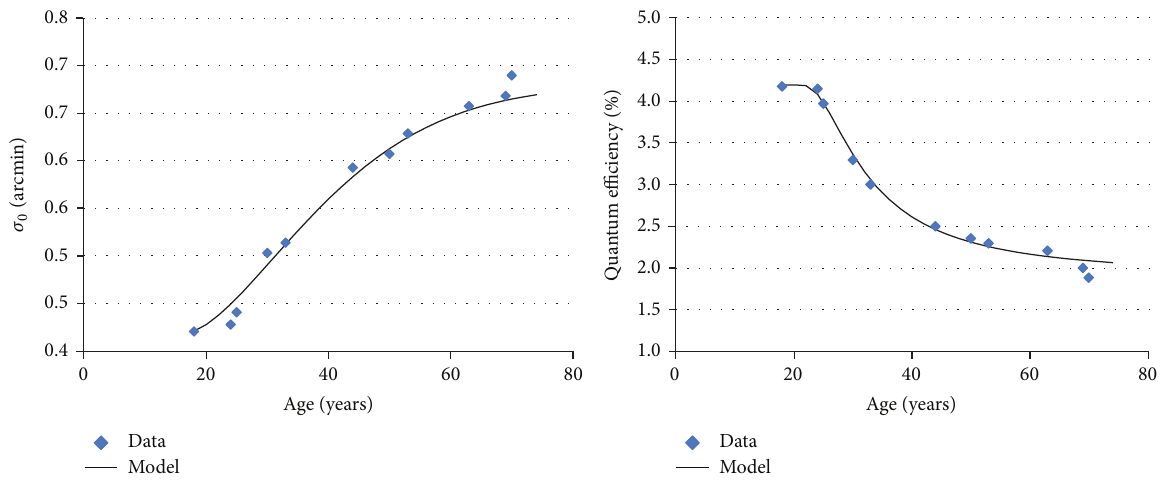
Figure 3: Modeling of 𝜎 0 and 𝜂 , using CSF data from Owsley et al., Tulunay-Keesey et al., and Elliott et al. [21, 65, 66].